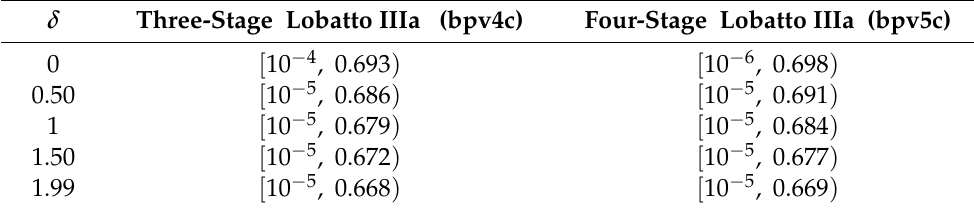
Table 6. Ranges of θλ 2 ensuring convergence with ghost solutions (Three-/Four-Stage Lobatto